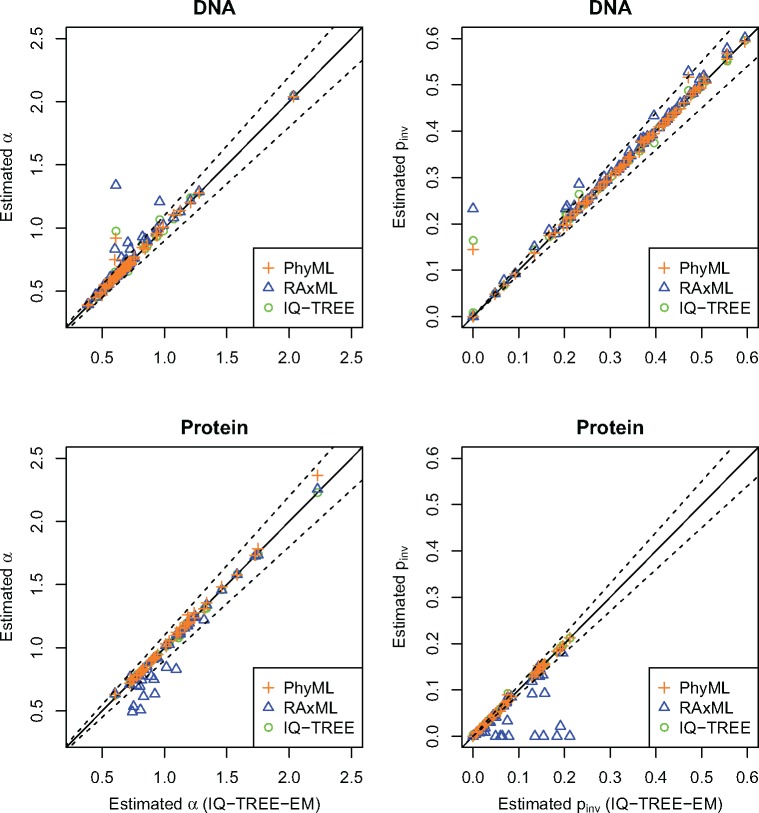
Estimation of \documentclass[12pt]{minimal}
\usepackage{amsmath}
\usepackage{wasysym} 
\usepackage{amsfonts} 
\usepackage{amssymb} 
\usepackage{amsbsy}
\usepackage{upgreek}
\usepackage{mathrsfs}
\setlength{\oddsidemargin}{-69pt}
\begin{document}
}{}$\alpha $\end{document} (left) and \documentclass[12pt]{minimal}
\usepackage{amsmath}
\usepackage{wasysym} 
\usepackage{amsfonts} 
\usepackage{amssymb} 
\usepackage{amsbsy}
\usepackage{upgreek}
\usepackage{mathrsfs}
\setlength{\oddsidemargin}{-69pt}
\begin{document}
}{}$p_{{\rm inv}}$\end{document} (right) for TreeBase alignments using IQ-TREE-EM (\documentclass[12pt]{minimal}
\usepackage{amsmath}
\usepackage{wasysym} 
\usepackage{amsfonts} 
\usepackage{amssymb} 
\usepackage{amsbsy}
\usepackage{upgreek}
\usepackage{mathrsfs}
\setlength{\oddsidemargin}{-69pt}
\begin{document}
}{}$x$\end{document}-axis) and IQ-TREE (circle), PhyML (cross) and RAxML (triangle). Dashed lines show the boundaries of 10% deviation from the IQ-TREE-EM estimates. Points above the upper dashed lines indicate overestimation compared with IQ-TREE-EM, whereas points under the lower dashed lines indicate underestimation.